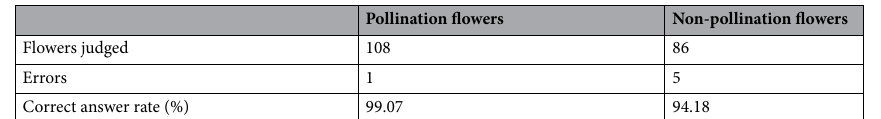
Table 2. Analysis accuracy of AI image classification machine. Correct answer rate = 1 - (errors/flowers judged).